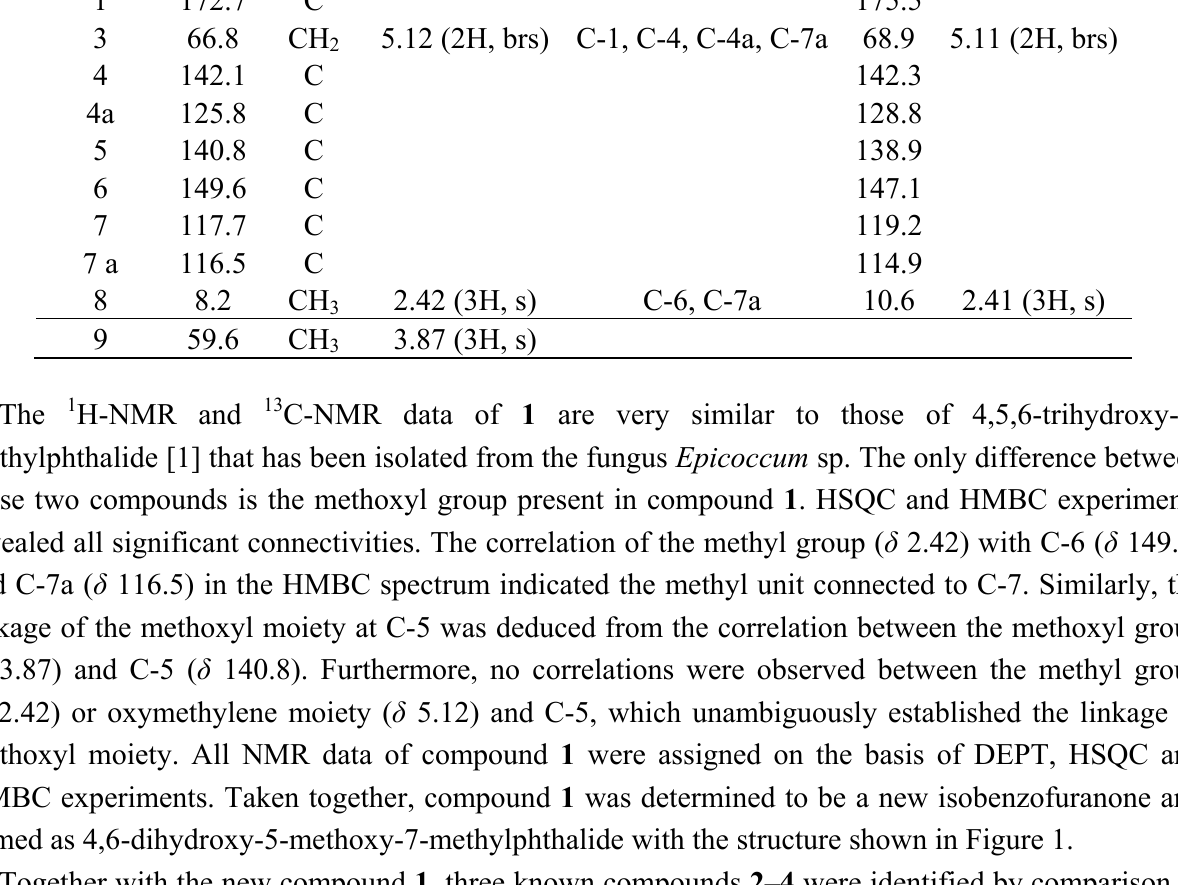
Table 1. 1 H- and 13 C-NMR data of 1 and 4 in CD